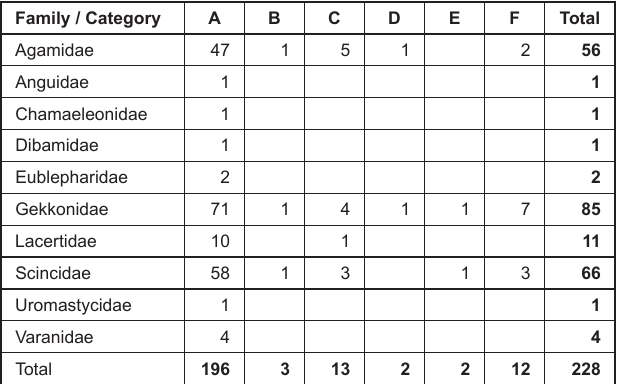
A - Species with valid distribution records within India B - Species reported from the regions politically disputed by India and Pakistan C - Species whose distributional records are invalid or questioned D - Species with unclear locality records E - Species known only from type specimen of unclear origin F - Species that were valid in earlier lists, but omitted in this